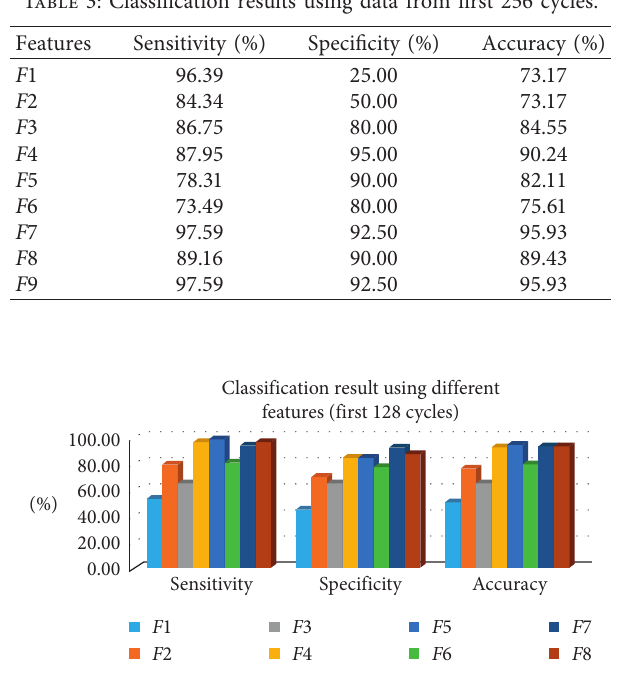
Figure 5: Classification result with data from first 128 cycles.